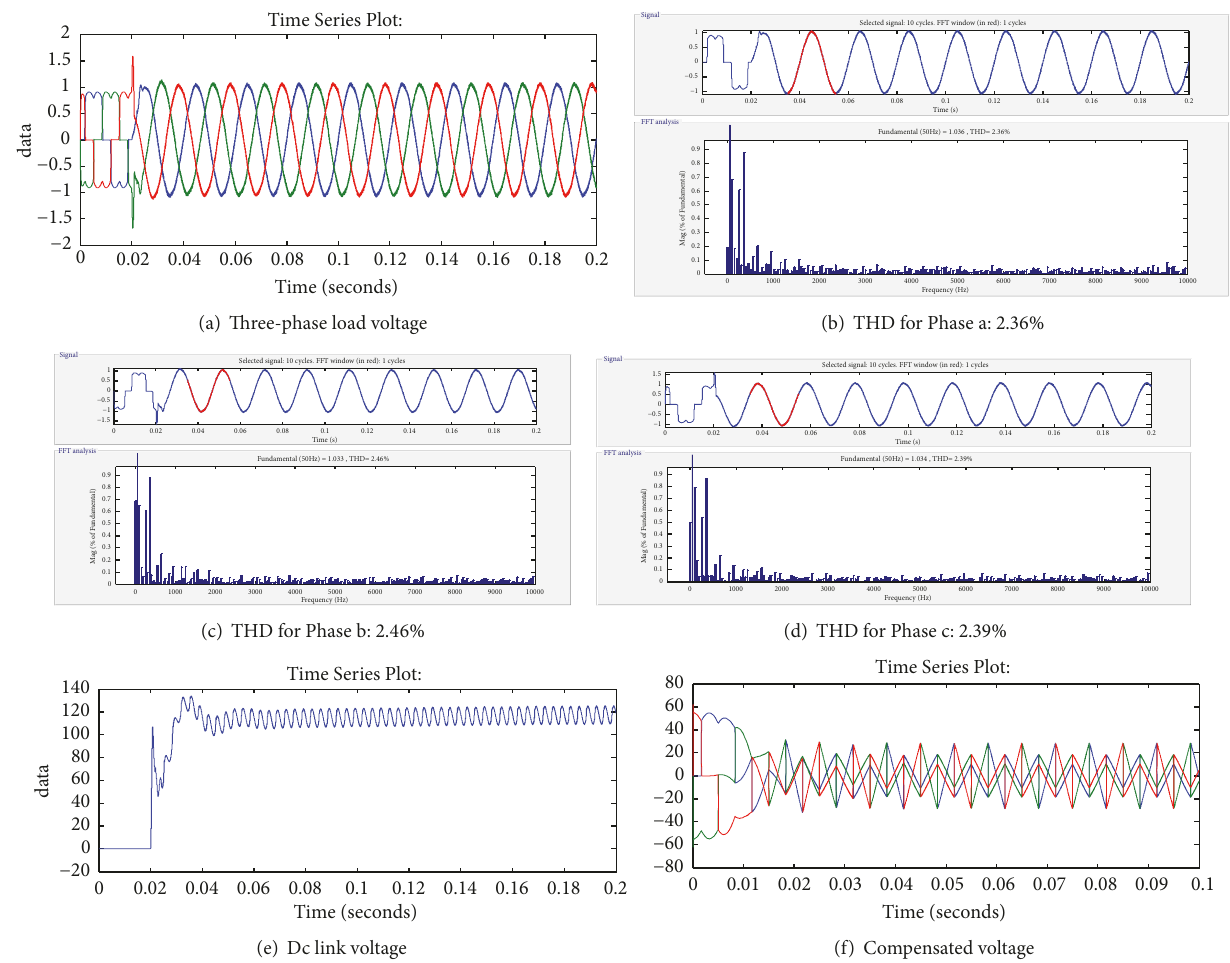
Figure8:PerformanceofloadvoltageandTHDvaluesofthree-phasevoltagesanddcbusvoltageandcompensationvoltageusingFSMPWM.